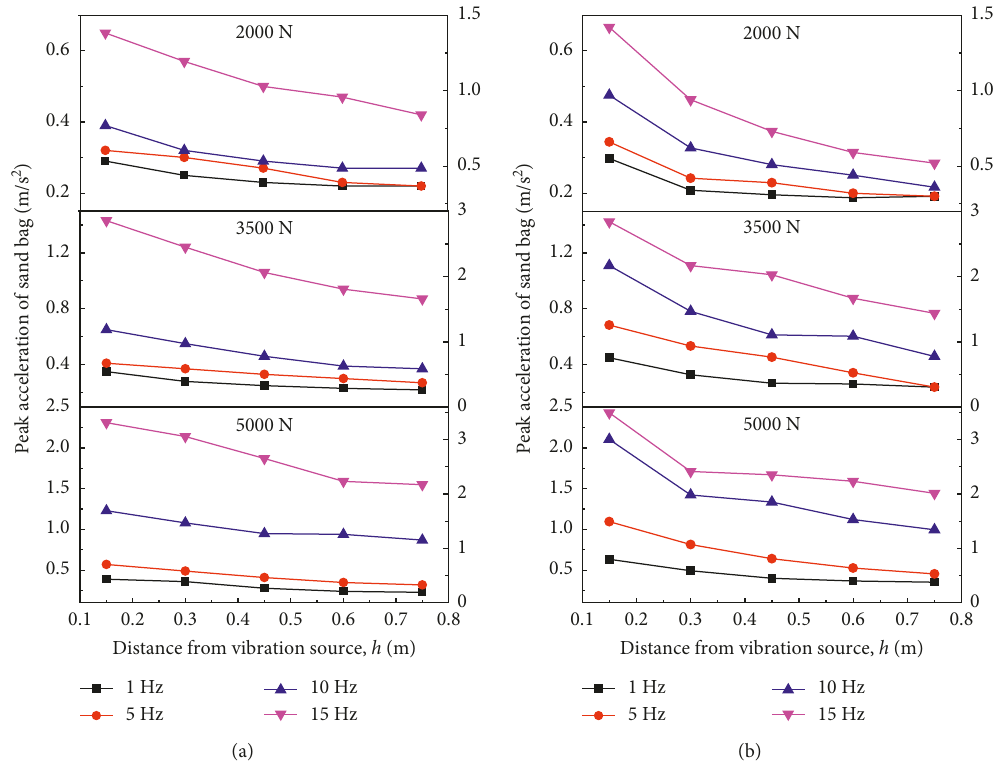
Figure 20: Peak acceleration for subgrade filled with sand bag under (a) single jack and (b) three jacks.